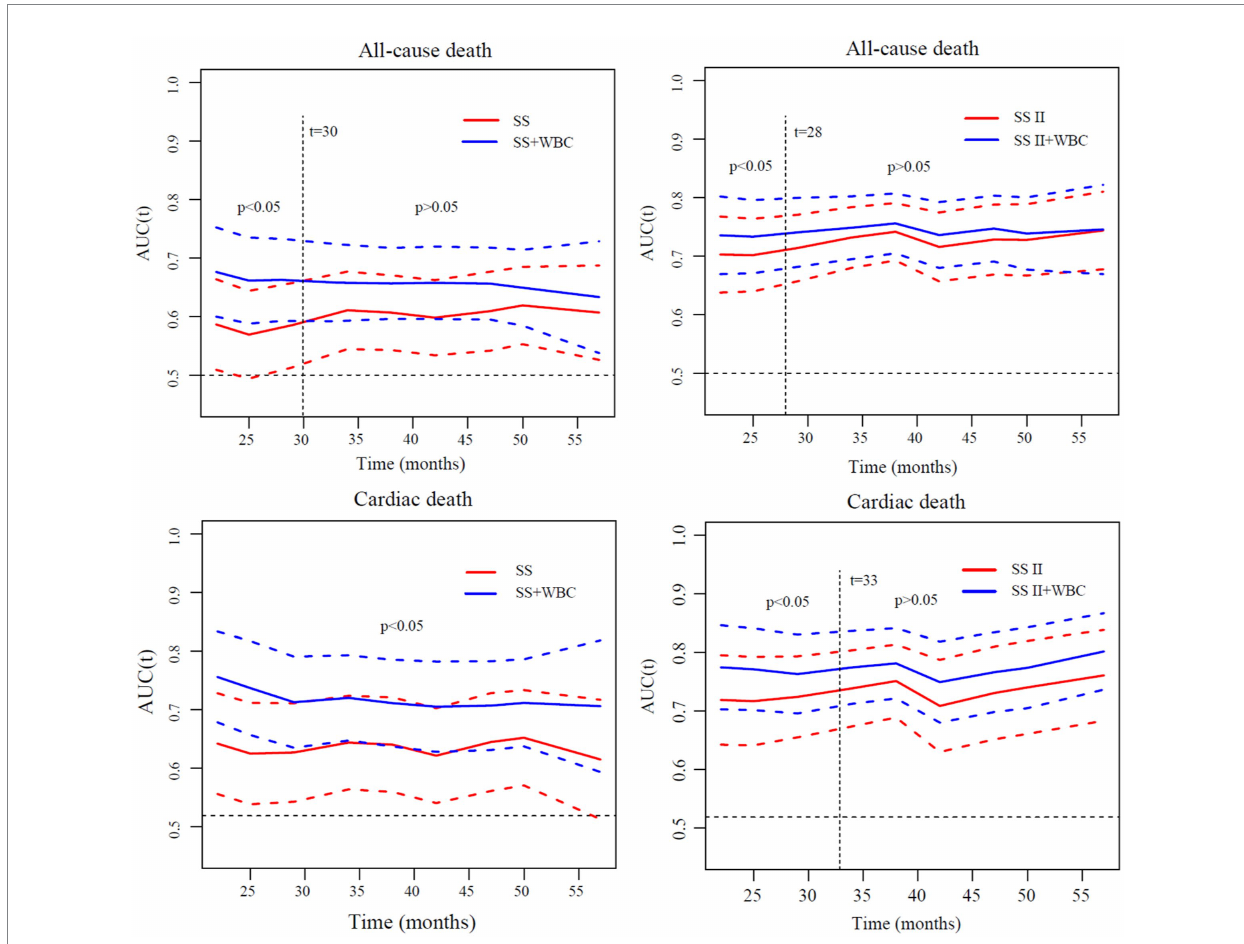
FIGURE 3 Comparisons of time-dependent AUCs of different models for discrimination of all-cause death and cardiac death. AUC, area under curve; SS, SYNTAX score; SS II, SYNTAX score II; WBC, white blood cell; SS II+WBC: SYNTAX score II plus white blood